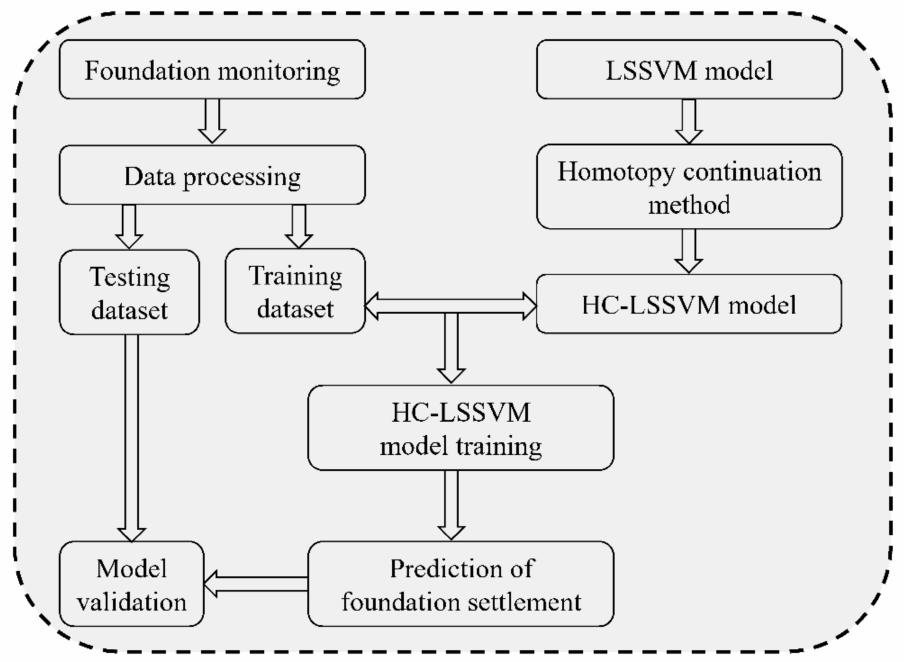
Figure 1. Research ideas and